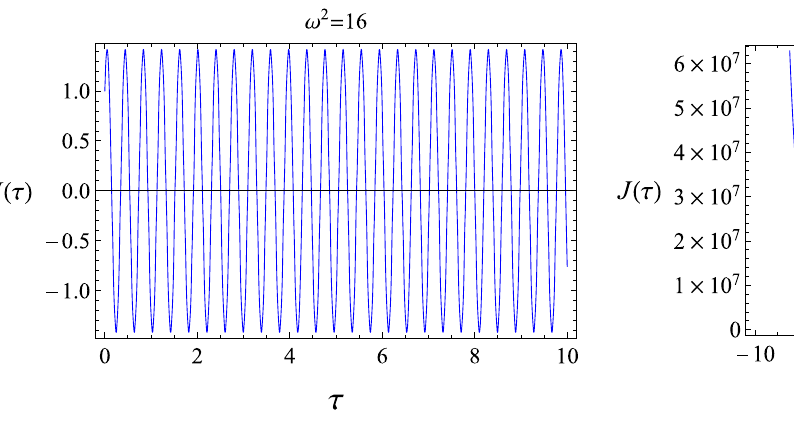
Fig. 7 Plots of the solution of Eq. (50) with different values of ω